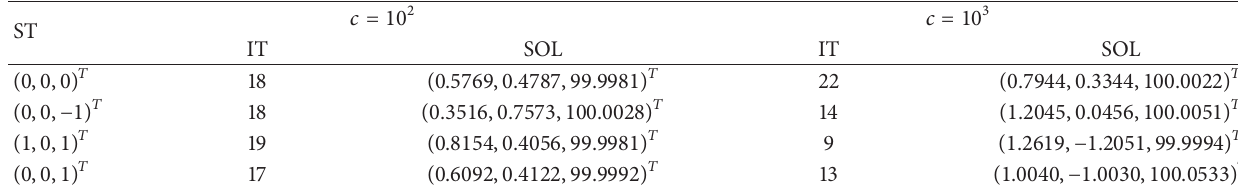
Table 4: Numerical results for Example 4 󸀠 .